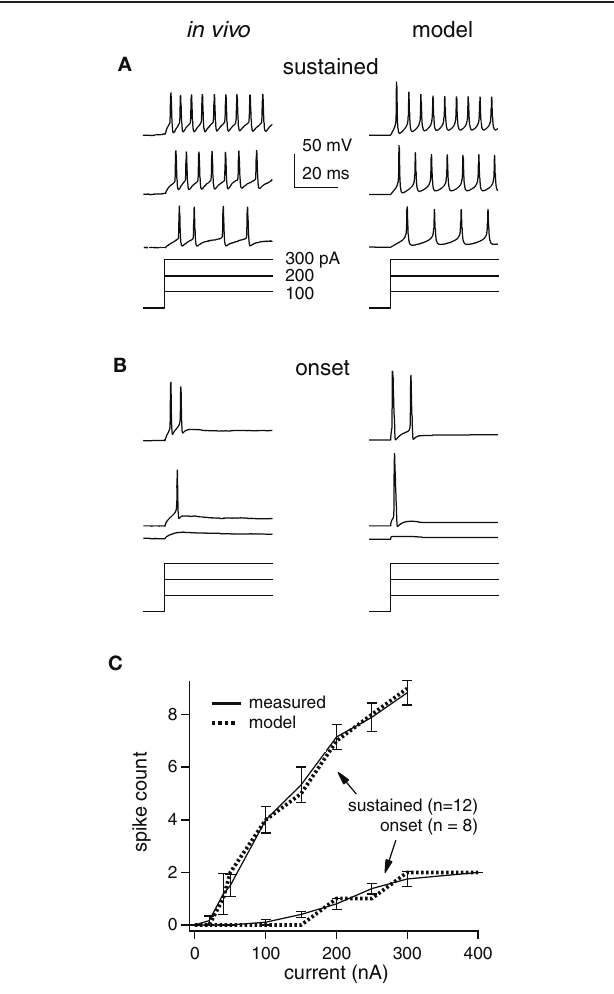
FIGURE 1 | Measured and modeled current-step responses match. (A) in vivo (left) and model cell (right) potentials (top) for a sustained cell stimulated with current steps (bottom). Scale bars and step sizes also apply to (B) . (B) Same as (A) for an onset cell. (C) Empirical and model I/O functions for average response of each cell